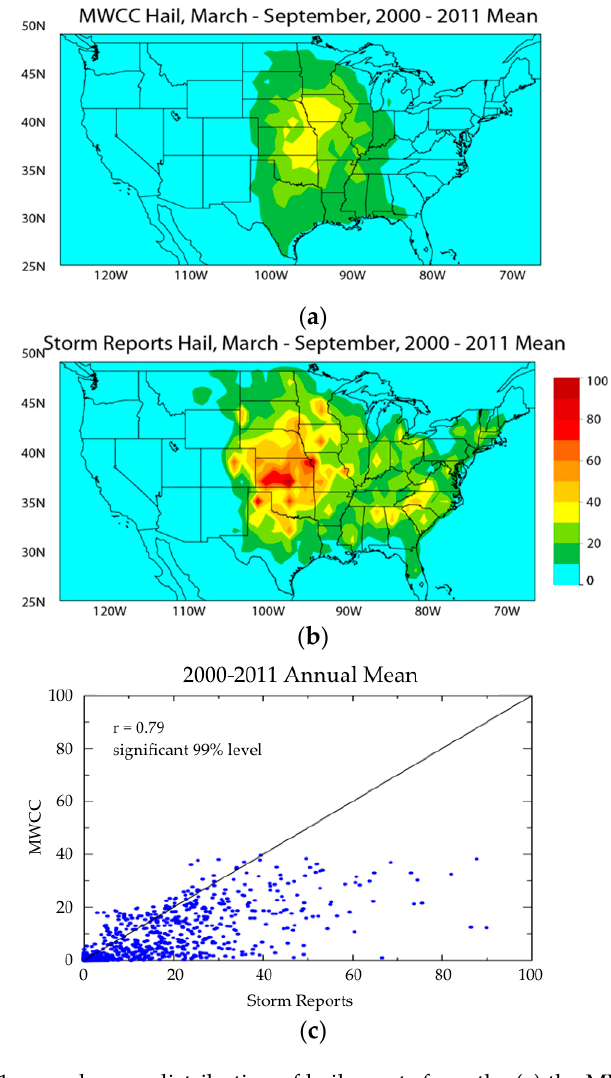
Figure 9. 2000–2011 annual mean distribution of hail events from the ( a ) the MWCC hail detection model and ( b ) surface storm reports; ( c ) scatter plot of the correlation between the two datasets.